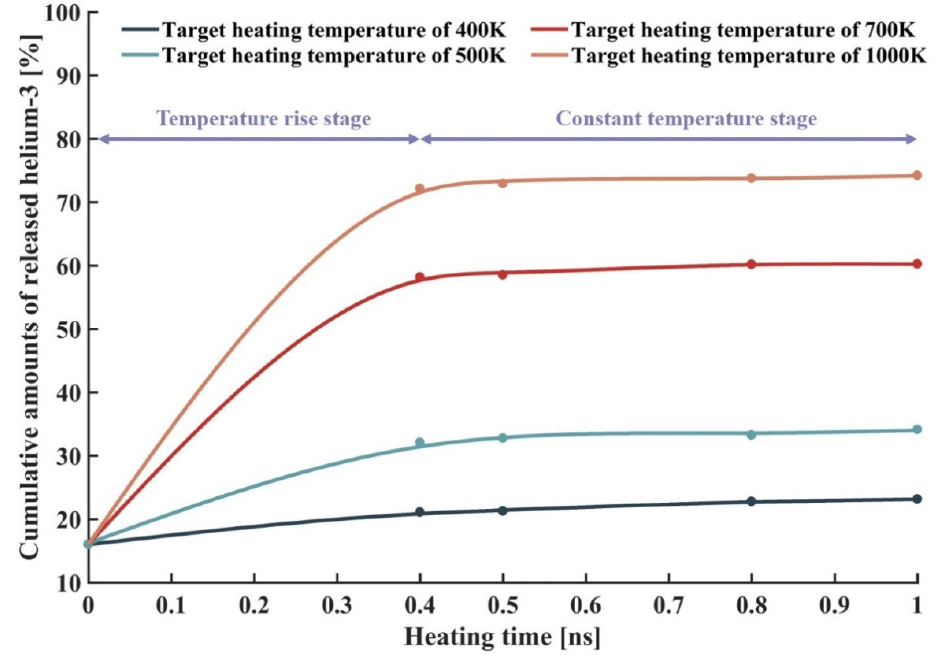
Figure 7. Variations in cumulative amounts of released helium-3 from the ilmenite with heating time at different target temperatures.